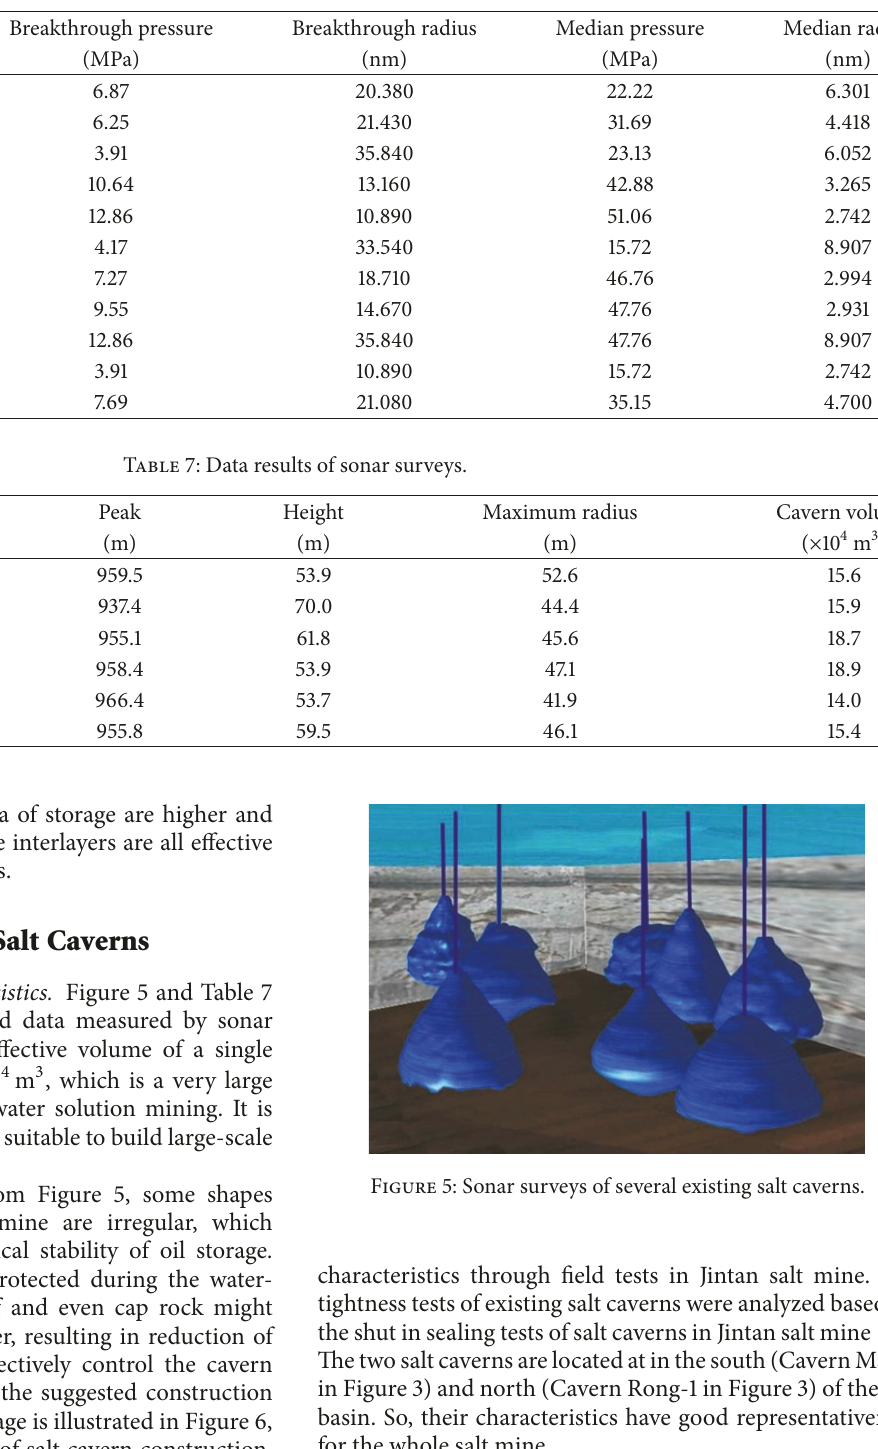
Table 6: MIP test results of interlayers in Well M1#.